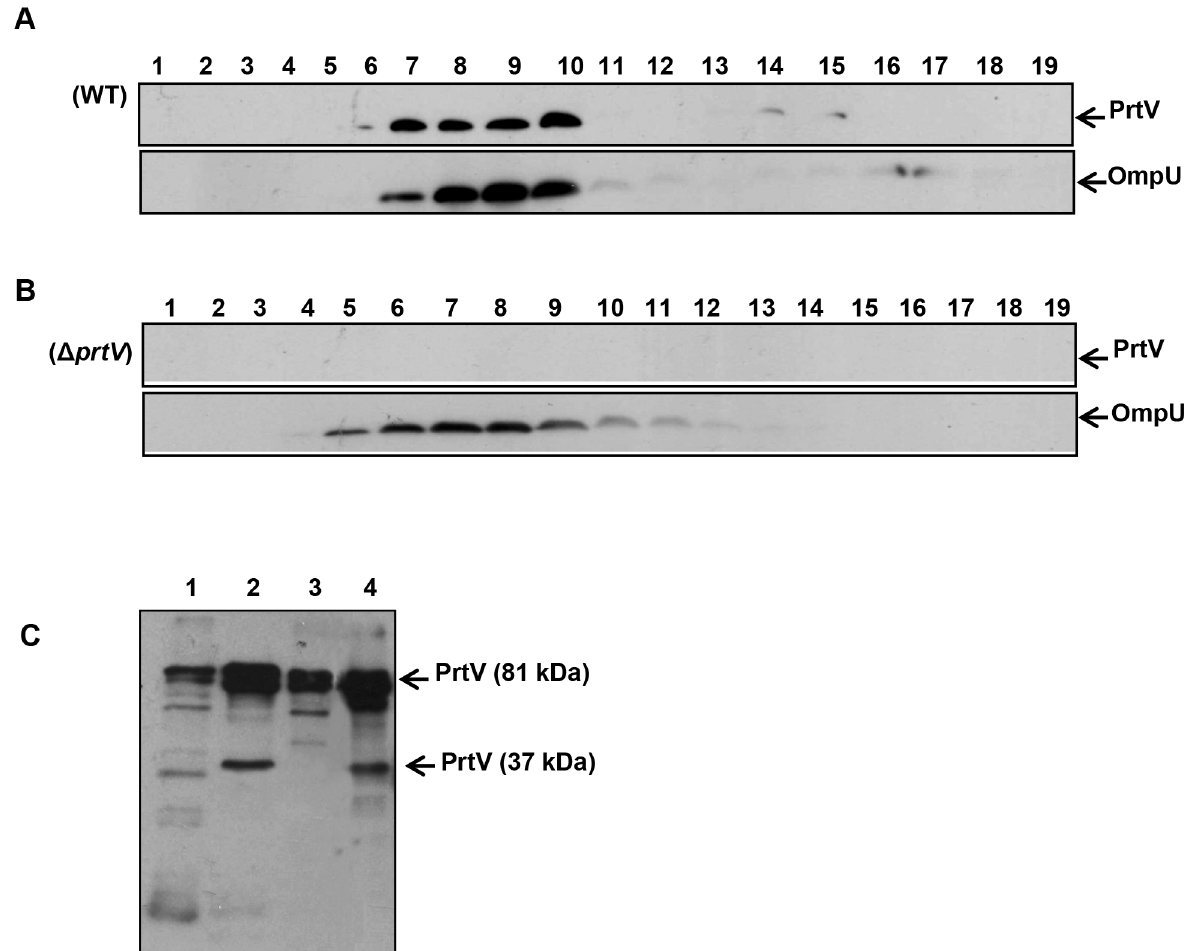
Fig 2. Presence of PrtV in OMVs from V . cholerae strain C6706. To detect the PrtV and the OmpU proteins in the density gradient fractions, immunoblot analyses were performed using polyclonal anti-PrtV and anti-OmpU antisera, respectively. (A) Immunoblot detection of PrtV (upper panel) and OmpU (lower panel) in density gradient fractions of OMVs from the wild type V . cholerae strain C6706. (B) Immunoblot detection of PrtV (upper panel) and OmpU (lower panel) in density gradient fractions of OMVs from the prtV mutant. (C) Immunobot detection of PrtV in the whole cell lysate (lane 1), culture supernatant before ultracentrifugation (lane 2), supernatant after the removal of OMVs (lane 3), and OMV sample (lane